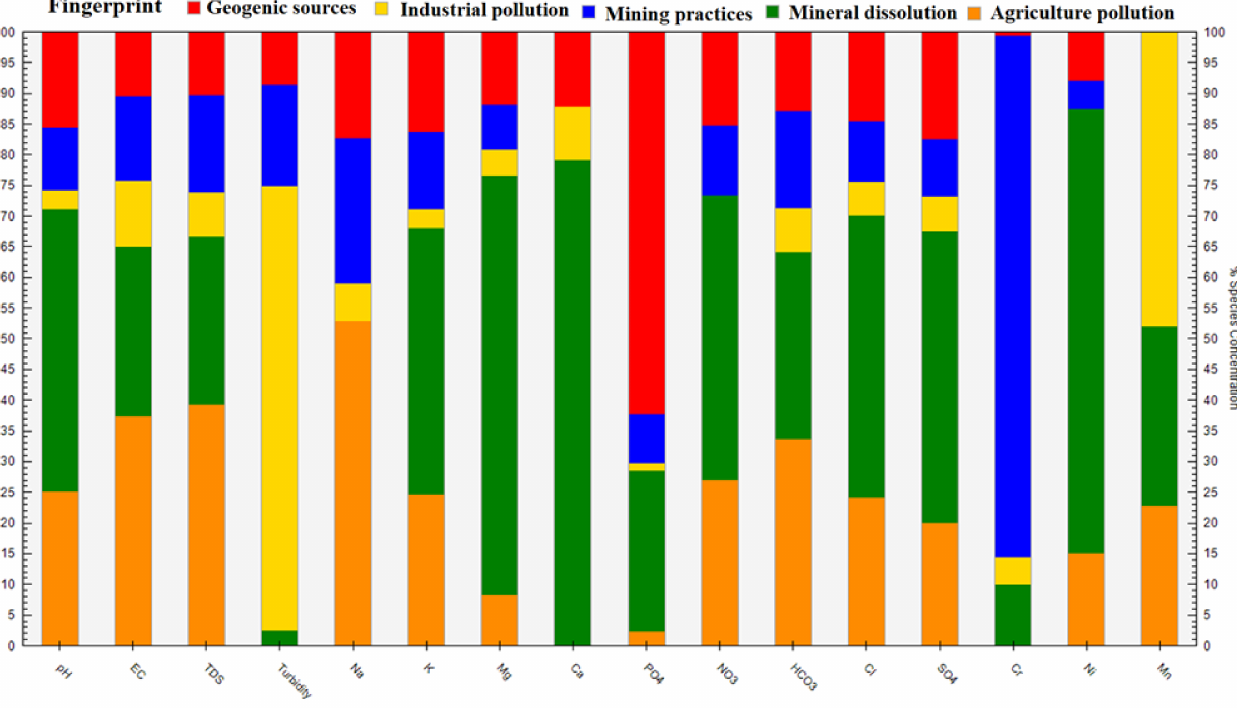
Figure 8. Fingerprints show the distribution of pollution sources in groundwater of the ultramafic terrain of Malakand, Northern